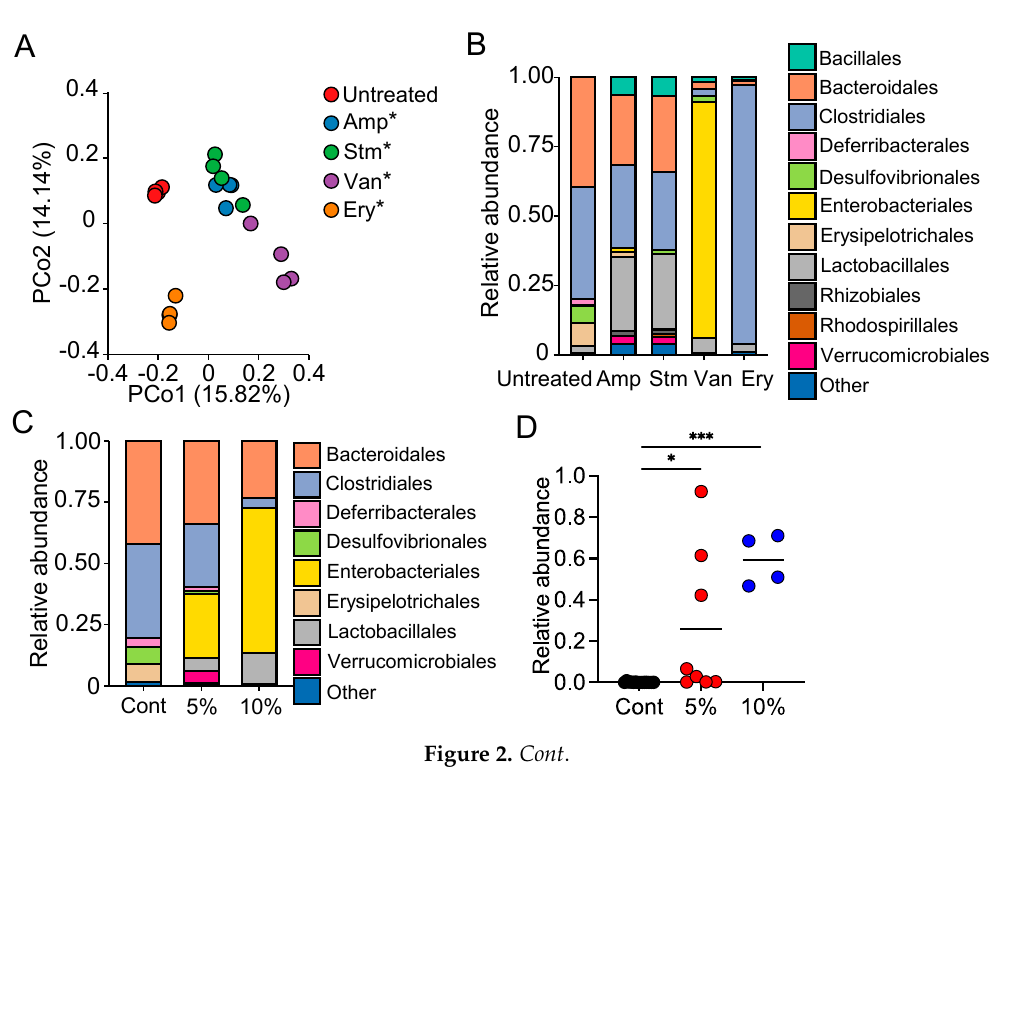
Figure 2. Identification of Enterobacteriaceae as Gut Bacteria Responding to Sorbitol. ( A ) Principal coordinate analysis (PCoA) plot generated using an unweighted UniFrac metric. Amp, ampicillin; Stm, streptomycin; Van, vancomycin; Ery, erythromycin. * p < 0.05 by PERMANOVA t -test. ( B ) Relative abundance of operational taxonomic units (OTUs) in fecal samples from C57BL/6J mice untreated or treated with antibiotics. The various colors correspond to each bacterial order indicated. Amp, ampicillin; Stm, streptomycin; Van, vancomycin; Ery, erythromycin. ( C ) Relative abundance of OTUs in fecal samples from sorbitol-treated C57BL/6J mice ( n = 4). The various colors correspond to each bacterial order indicated. Cont, control; 5%, 5% sorbitol; 10%, 10% sorbitol. ( D ) Relative abundances of OTUs assigned to the family Enterobacteri- aceae. Cont, control; 5%, 5% sorbitol; 10%, 10% sorbitol. Each dot represents an individual mouse and the horizontal bars indicate mean values. *** p < 0.001, compared with the control group using Dunnett’s t -test. ( E ) Relative abundances of OTUs assigned to the genera of the family Enterobacteriaceae. Bars in the graph are mean values. Each circle represents an individual mouse. *** p < 0.001 compared to the Cont group using Steel’s test. Cont, control; Amp, ampicillin; Stm, streptomycin; Van, vancomycin; Ery, erythromycin. 3.3. E. coli Degraded Sorbitol and Suppressed Sorbitol-Induced Diarrhea To confirm that Enterobacteriaceae suppressed sorbitol-induced diarrhea by con- suming sorbitol in the colon, we isolated Enterobacteriaceae bacteria which abundance was increased by sorbitol and/or vancomycin treatment, including E. coli , Citrobacter far- meri , Klebsiella pneumoniae , Enterobacter spp ., and Proteus mirabilis , and assessed their ability